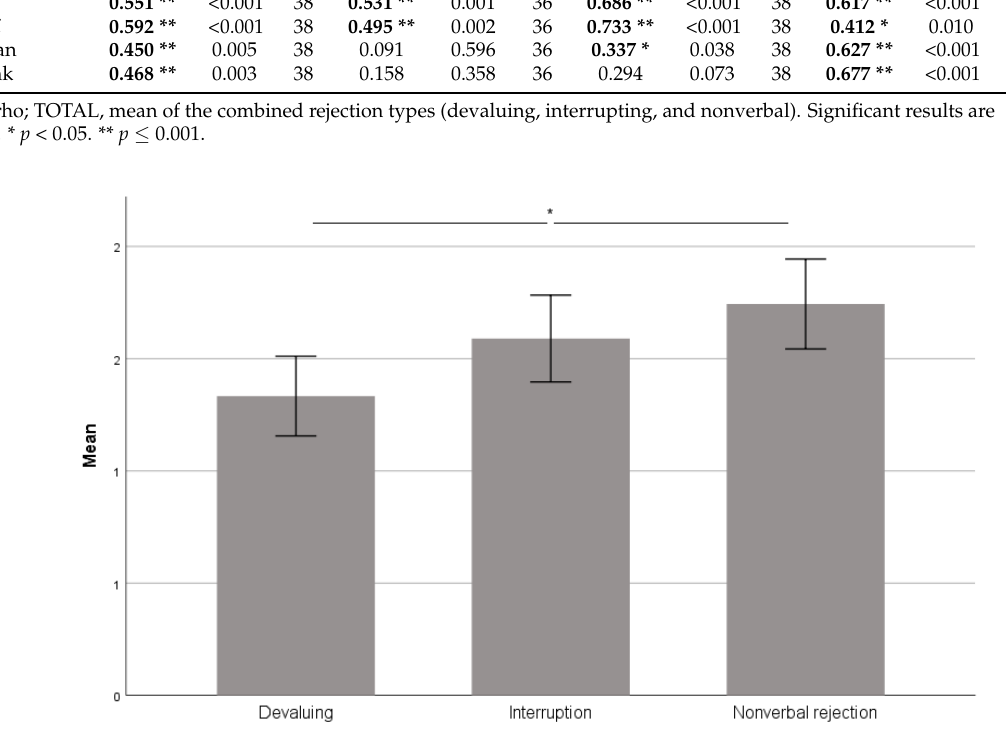
Figure 2. Self-reported stress during improvisation exercises. Scale 0 to 5 (0 = not stressed at all, 5 = extremely stressed). Error bars: +/ − 1 SE (* p < 0.05; FDR < 0.1).